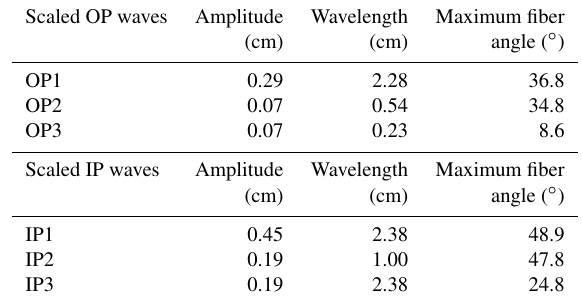
Table 2. OP and IP wave parameters as scaled for use in the coupon testing